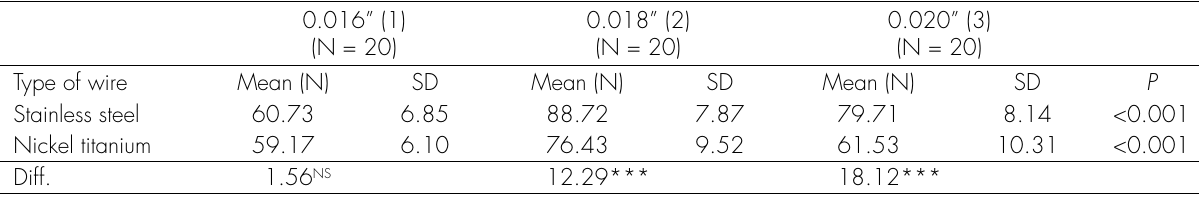
Table IIa. Mean force levels in newtons (N) required to cause axial dislodgement of nickel titanium compression hooks placed on 0.016” (1), 0.018” (2), and 0.020” (3) stainless steel and nickel titanium arch wires. Descriptive data and results of the one-way analysis of variance ( p ). Diff. = differences between the mean values in the stainless steel and nickel titanium groups data in the respective wire size groups.